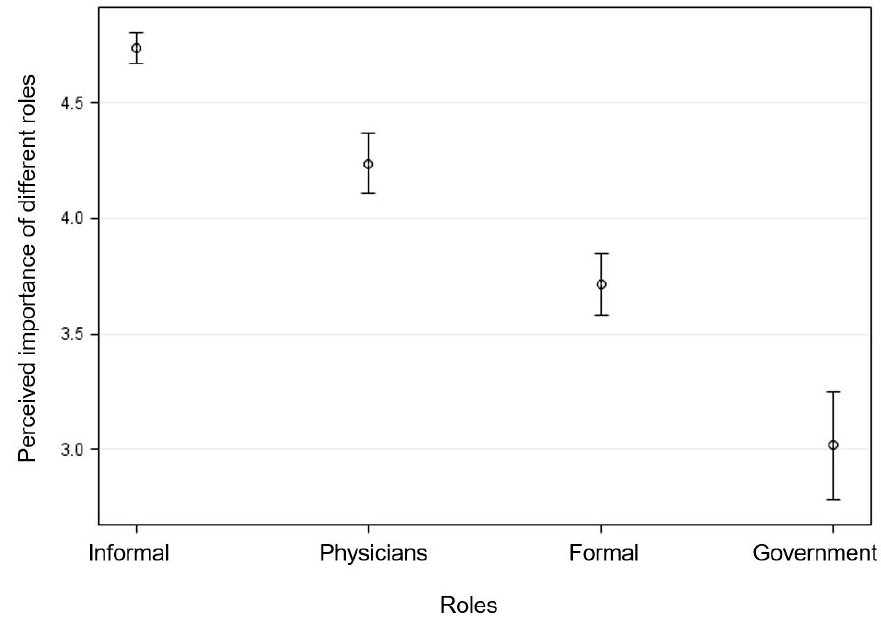
Figure 1. Estimated mean with 95% confidence interval for medical students’ perceived importance of different roles in reducing childhood obesity (score ranging from 1 to 5, with a higher score indicating greater importance).